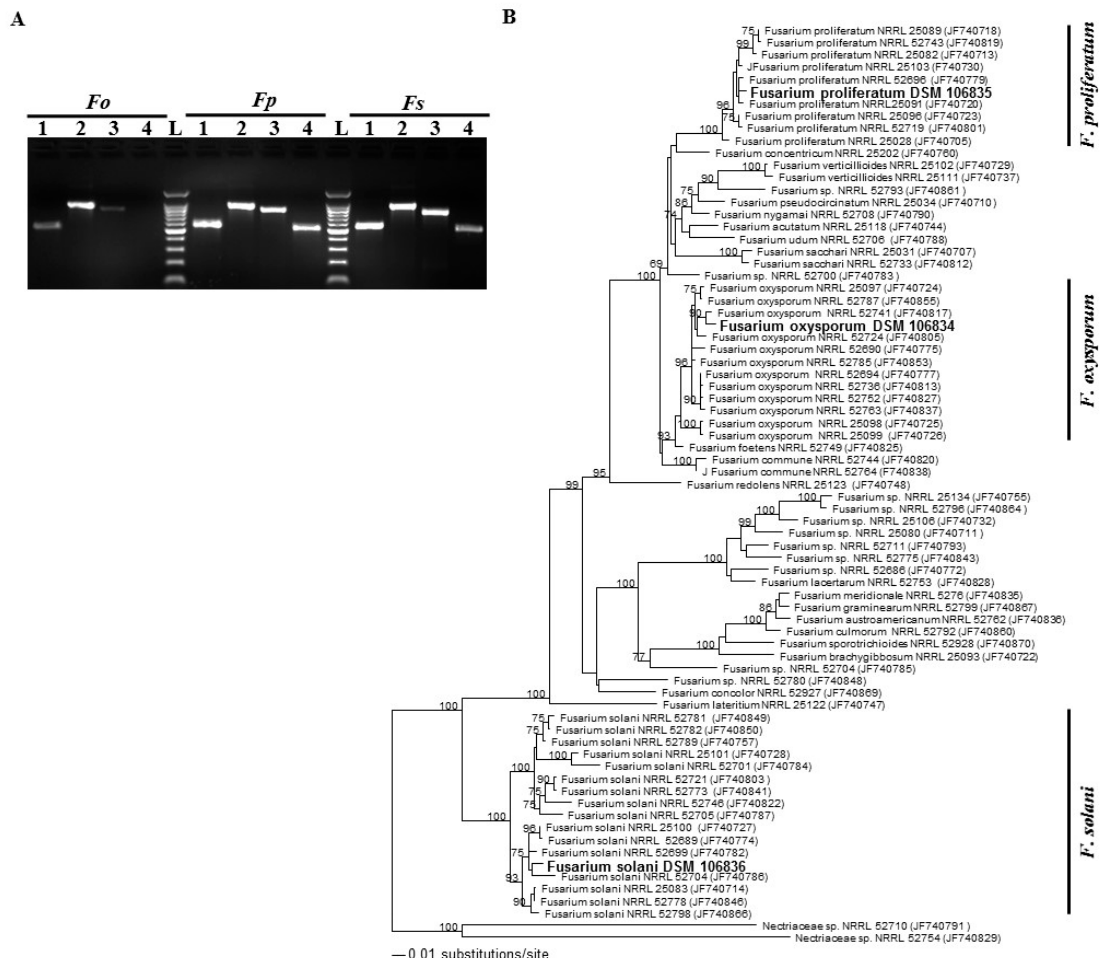
Figure 3. Identification of Fusarium spp. at the molecular level. PCR amplification of specific genomic DNA regions of infected root tissues ( A ); and dendrogram showing phylogenetic relationships among F. oxysoprum ( Fo ) species complex (DSM 106834), F. proliferatum ( Fp ) (DSM 106835), and F. solani ( Fs ) species complex (DSM 106836) identified in this study and other members of Fusarium spp. prepared